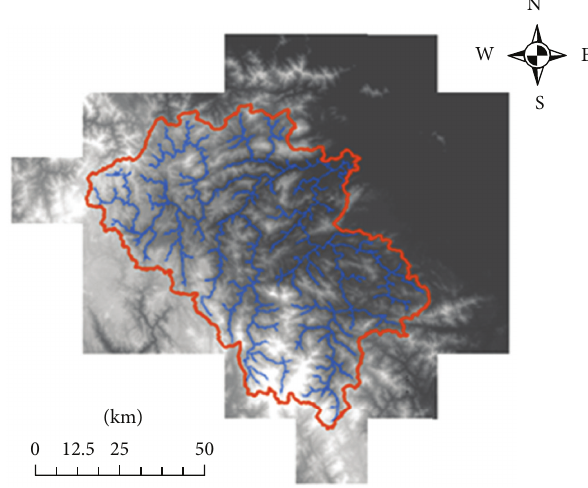
Figure 3: Watershed delineation using ArcHydro 9.1.